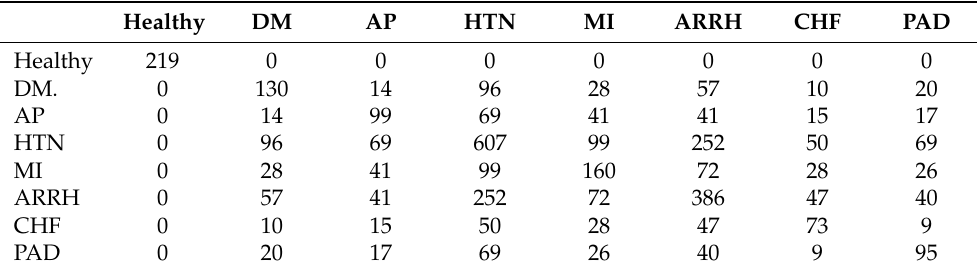
Table 1. Clinical characteristics of the males’ group of ILSA database. (AP, angina pectoris; ARRH, arrhythmia; CHF, congestive heart failure; DM, diabetes mellitus; HTN, hypertension; MI, myocardial infarction; PAD, peripheral artery